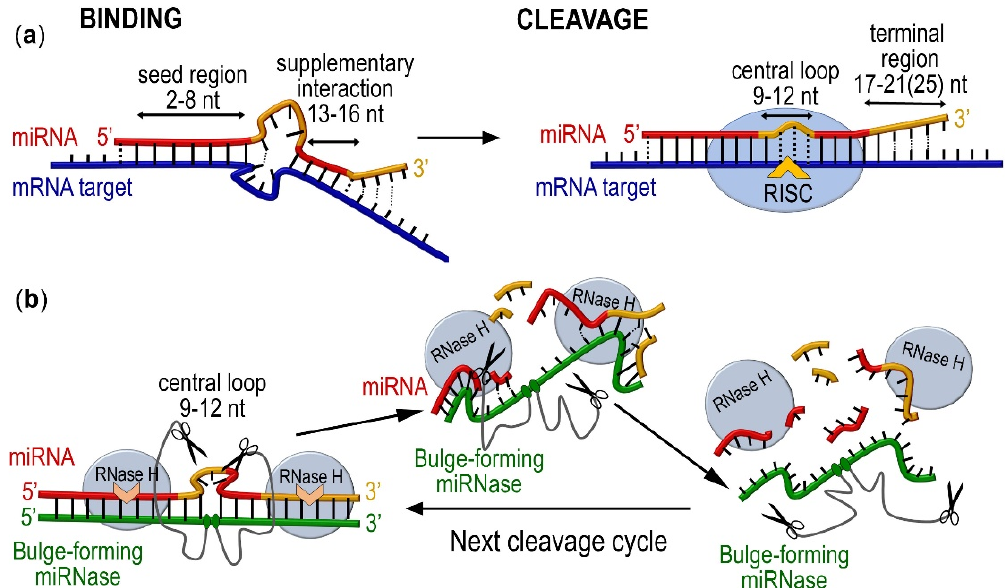
Figure 7. Functionally significant regions in the miRNA molecule which can be used as target sites for catalytic destruction by a combination of bulge ‐ forming miRNase and RNase H. ( a ) Cellular mechanism of miRNA ‐ guided mRNA repression through binding with the miRNA seed region (2–8 nt) reinforced by hybridization with the supplementary interaction region (13–16 nt), followed by RISC ‐ mediated cleavage at the mRNA target site aligned with the miRNA central loop (9–13 nt). ( b ) Proposed strategy for knockdown miRNA through synergetic cleavage by BC–miRNase and RNase H, when the cleavage at the central loop of miRNA is catalysed by BC–miRNase, while the